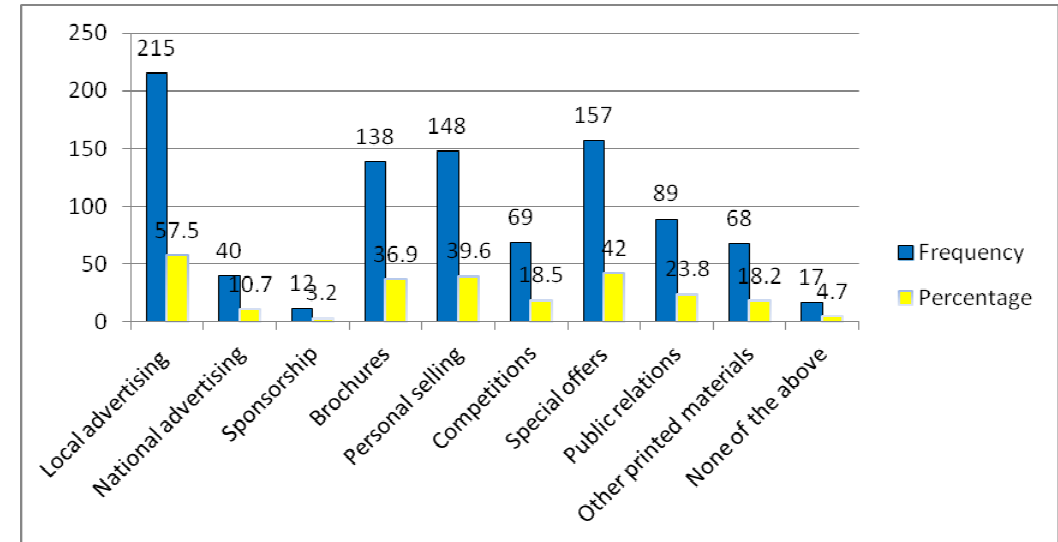
Figure 2: Marketing communications methods used by respondents